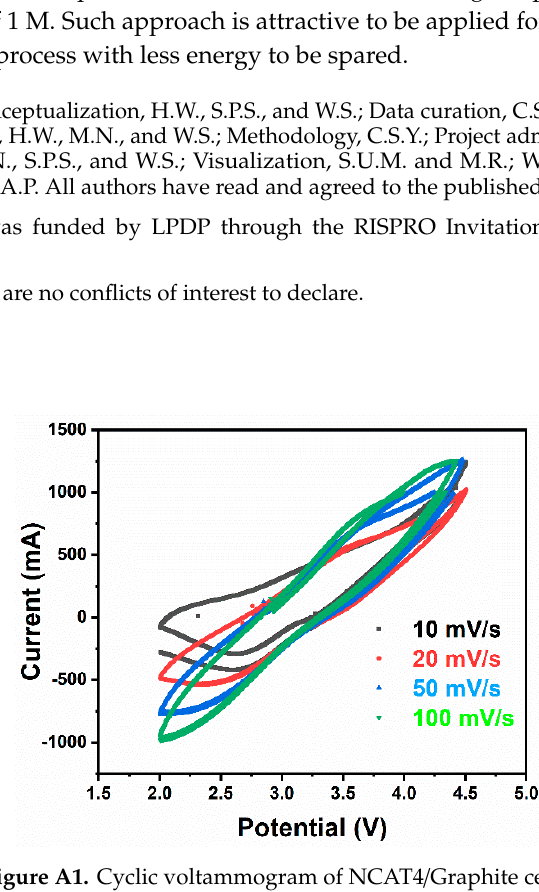
Figure A2. Additional cycle performance of NCAT4 cells. References 1.